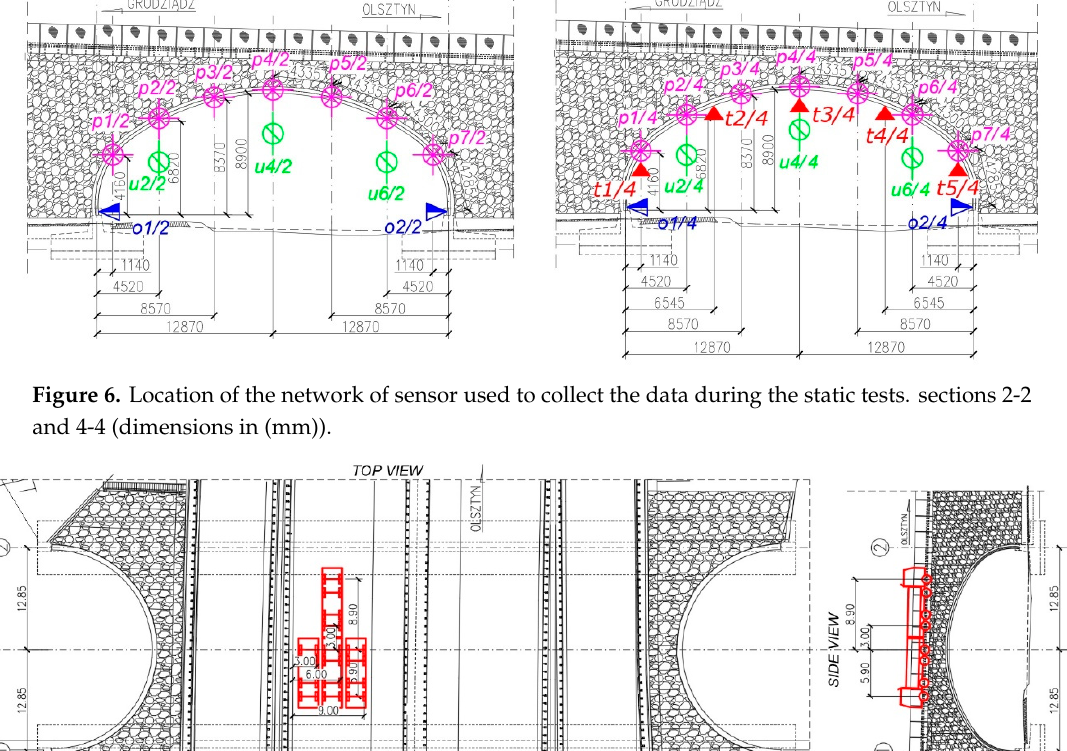
Figure 6. Location of the network of sensor used to collect the data during the static tests. sections 2- 2 and 4-4 (dimensions in (mm)).